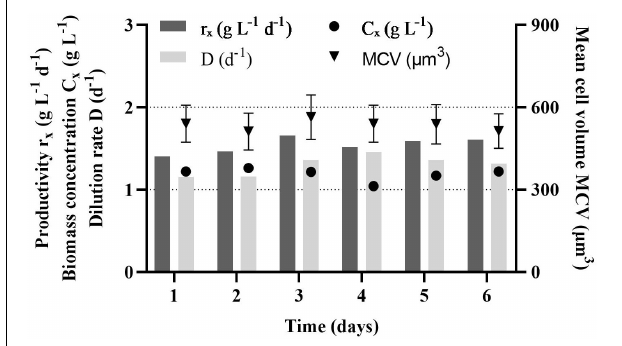
FIGURE 1 | Steady state volumetric productivity (rx), dilution rate (D), biomass concentration (Cx) and mean cell volume (MCV) of Rhodomonas sp. in a photobioreactor during the growth phase.